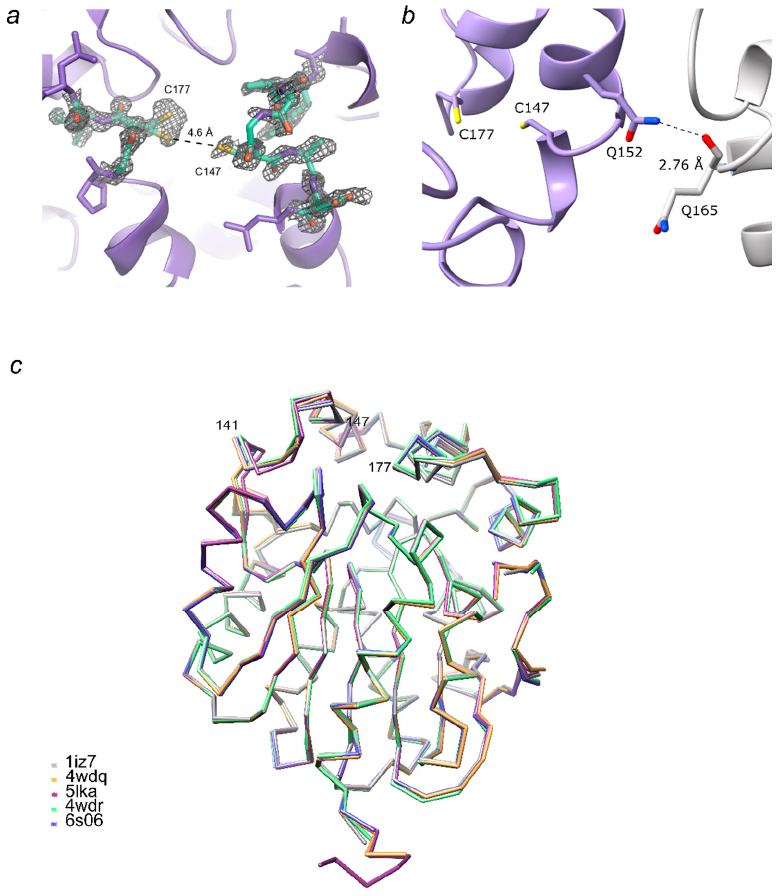
Figure 3. Structure details of LinB D147C+L177C and overlay of LinB variants. ( a ) Electron density map contoured at 1 σ for the substituted residues Cys147 and Cys177 with neighboring residues; the residues 144–150 and 176–178 are displayed as sticks and colored by the elements; ( b ) crystal contact represented by hydrogen bond between amino group of Gln152 and backbone oxygen of Gln165 of symmetry-related molecule; ( c ) LinB variants are shown as a backbone only, LinB WT (PDB ID: 1iz7, [25]) in grey; LinB L177W (PDB ID: 4wdq, [12]) in orange; LinB W140A+F143L+L177W+I211L in purple (PDB ID: 5lka, resolution 1.30 Å, chain A, [12]) and green (PDB ID: 4wdr, resolution 2.50 Å, chain A, [12]); and LinB D147C+L177C (PDB ID: 6s06, this study) in